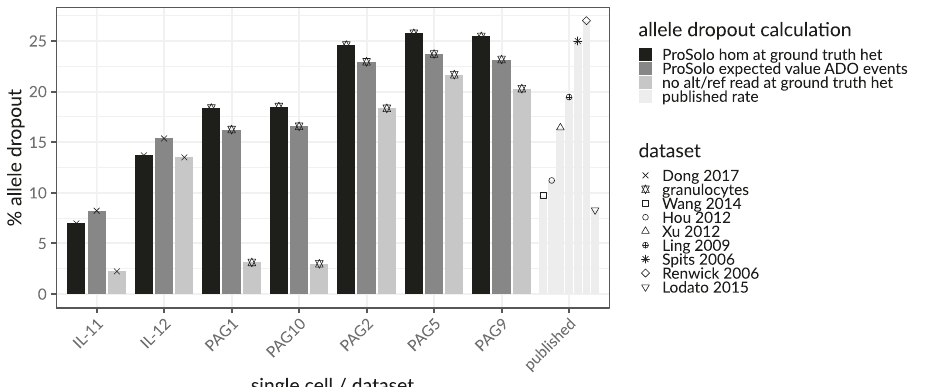
Fig. 2 Concordance of three differently calculated per-cell (IL-1 and PAG cells) allele dropout rates across ground truth heterozygous sites, in the context of allele dropout rates from the literature 21,22,26,32 – 36 . The expected value of the allele dropout events in ProSolo (dark gray) is concordant with the number of false homozygous genotype calls made by ProSolo on those sites (black) and both values are well within the range of published allele dropout rates for single-cell MDA sequencing data ( “ published ” , to the right, very light gray). The naive allele dropout rate (light gray) — calculated as ground truth heterozygous sites with a minimum coverage of seven and either no read with the reference allele or no read with the alternative allele — -shows discrepancies with ProSolo ’ s estimates of allele dropout for samples with a more uniform coverage (IL-11, PAG1, PAG10, Supplementary Fig. 3).